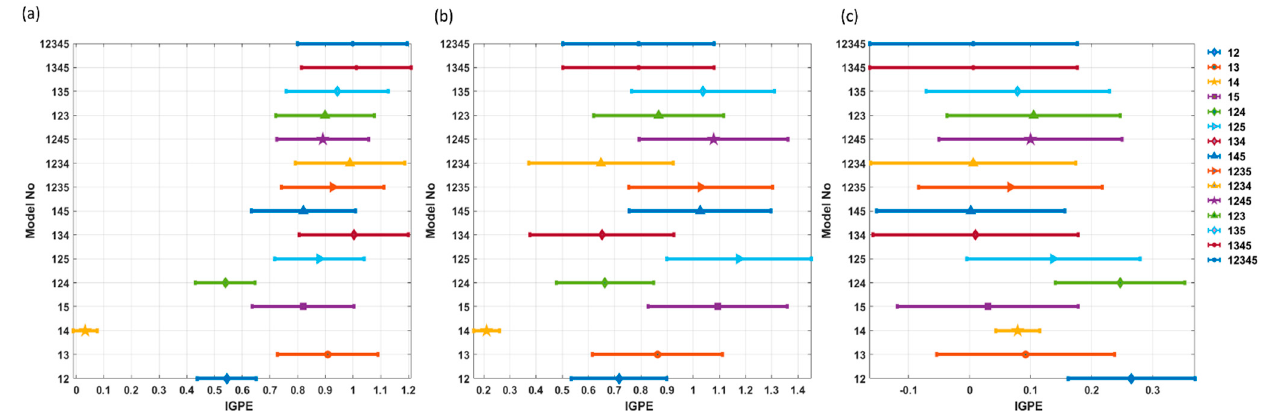
Figure 5. Information gain per earthquake of hybrid models relative to SUP baseline model with the HWS strain rate covariate. The combination of covariates contributing to each hybrid is indicated by the model number, which is a composite of the numbers corresponding to the baseline model and selected covariates, as follows: 1-SUP; 2-PPI; 3-PMF; 4-FLT; 5-HWS. ( a ) Fitting period (1987–2006); ( b ) Forward testing period (2012–2015); ( c ) Reverse testing period (1951–1986). Error bars are 95% confidence intervals.